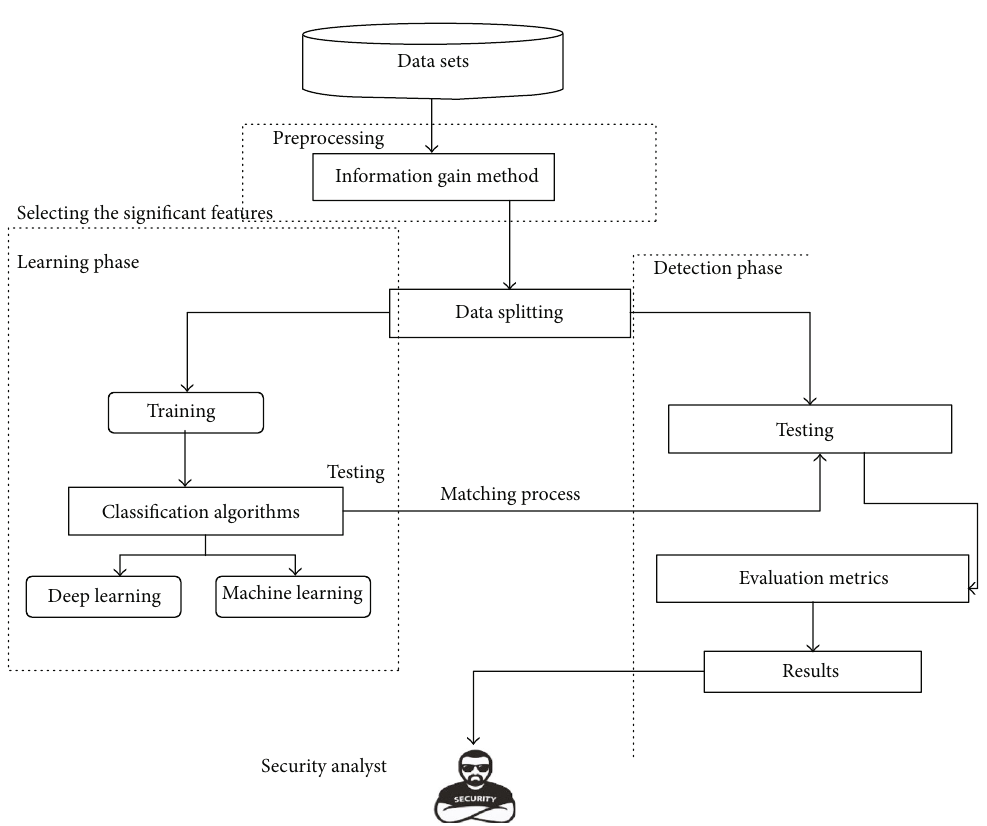
Figure 1: Framework for proposed